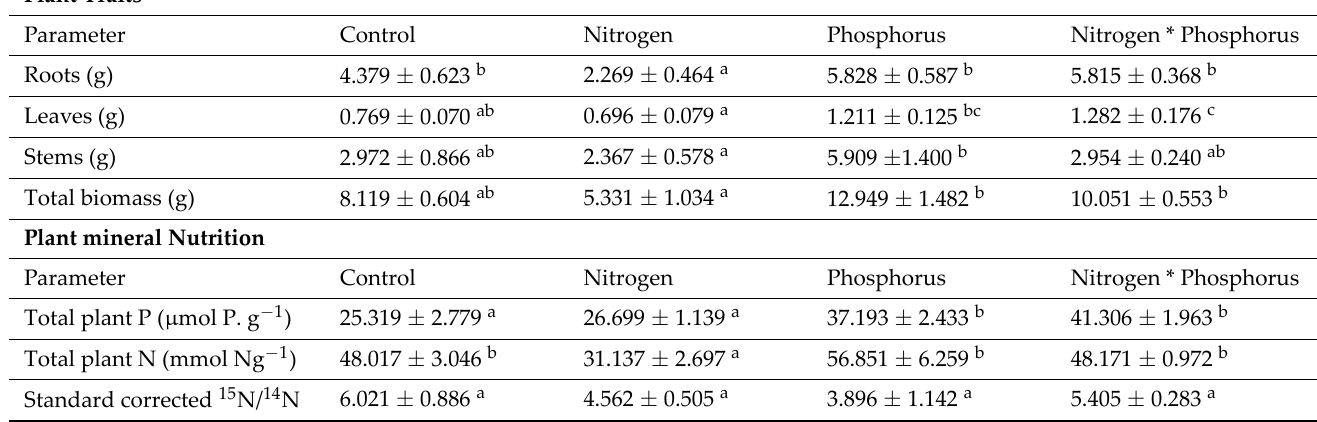
Table 2. Vachellia sieberiana biomass and mineral nutrition grown in control soils (no nutrients) and soils enriched with nitrogen (limestone ammonium nitrate), phosphorus and both nitrogen (lime‑ stone ammonium nitrate) and phosphorus obtained from the Ukulinga Grassland Nutrient Experi‑ ment, South Africa. Different letters indicate significant differences among treatments per parameter, at p ≤